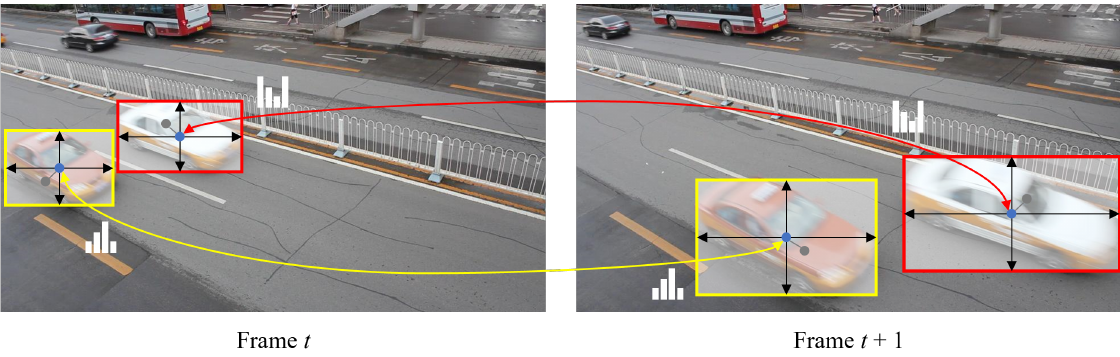
Figure 4. Visualization of online association. The frames are selected from the sequence MVI-40181 in the UA-DETRAC-train set, with a time interval of approximately 10 frames for better